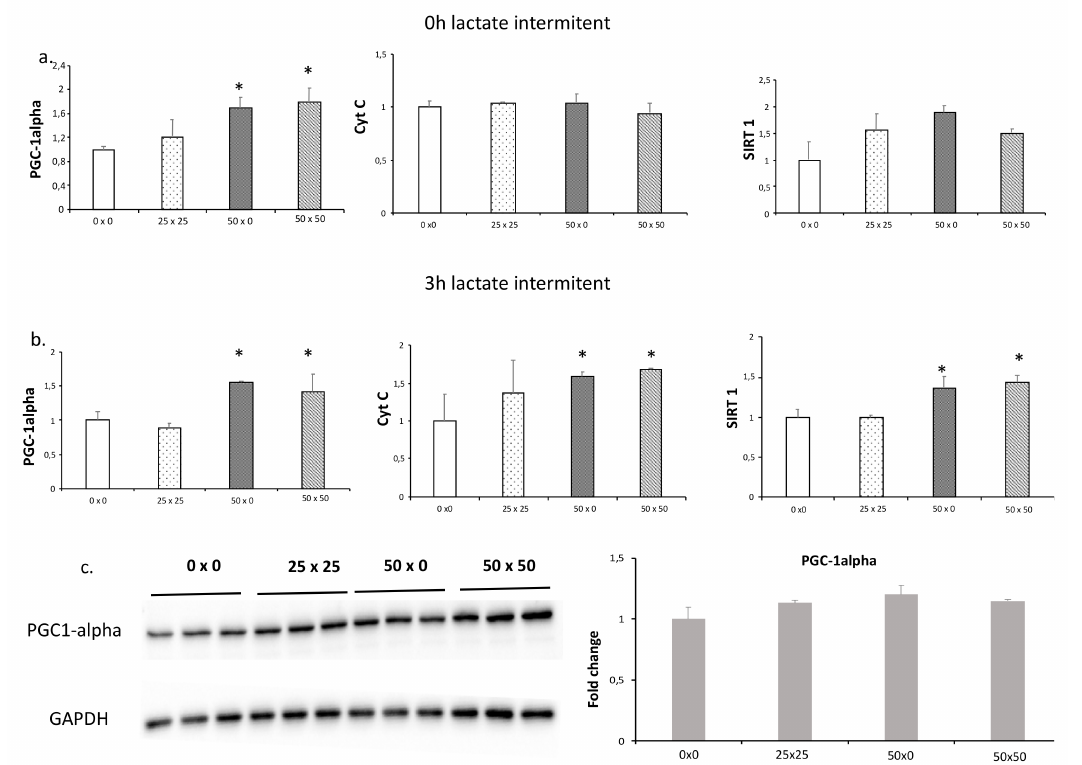
Figure 3. qPCR analysis for intermittent and continuous exposure to lactate in C2C12 myotubes and Western blot of PGC1-alpha after continuous or intermittent exposure to lactate. C2C12 myotubes were cultured with di ff erent concentration patterns of L-lactate (see Table 1). Samples for qPCR analysis were obtained 0 ( a ) and 3 h ( b ) after the exposure series. Samples for Western blot ( c ) were obtained 3 h after the exposure series (see Table 1). In the time between lactate culture and sample collection (zero or three hours), cells were cultured with DM. Error bars show standard deviations. * p < 0.05 from non-lactate exposure (0 × 0). RNA experiments were performed three independent times with three replicates each time, and protein experiments with three independent